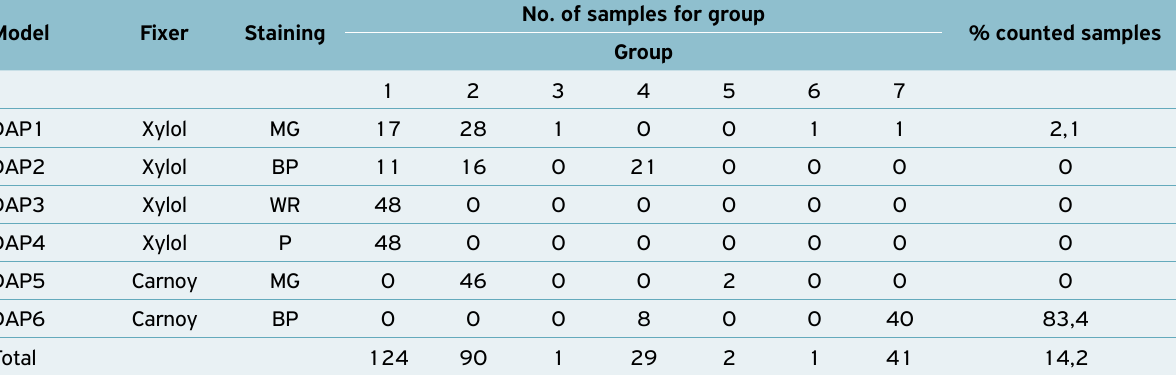
Table 1. Methods of fixation and staining of milk film for somatic cell count of ovine milk and the percentage of samples likely to count, according to the slides